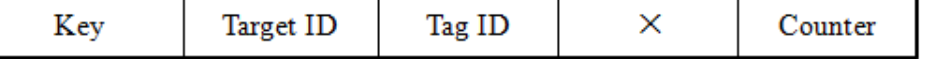
Figure 7. RFID tag’s signal format after searching for links to the outside of the